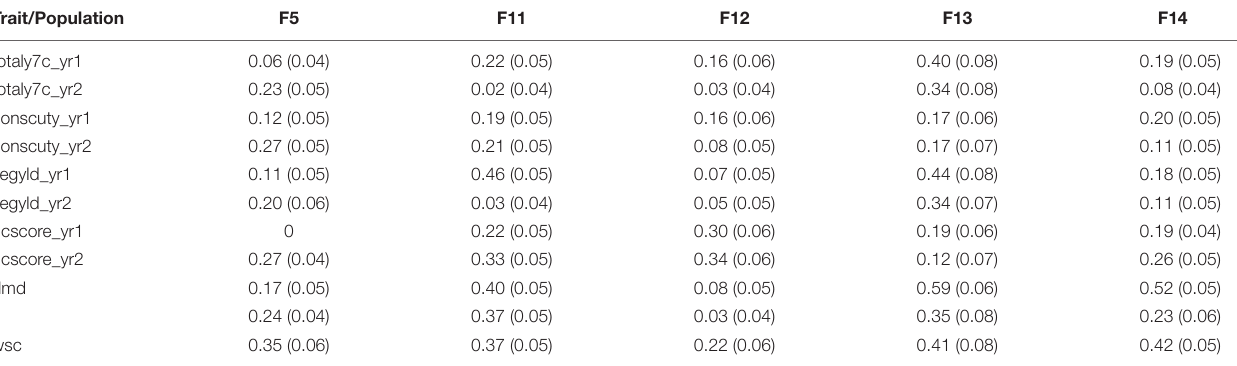
TABLE 1 | Broad-sense heritability for different generations and traits of the breeding populations. Trait/Population F5 F11